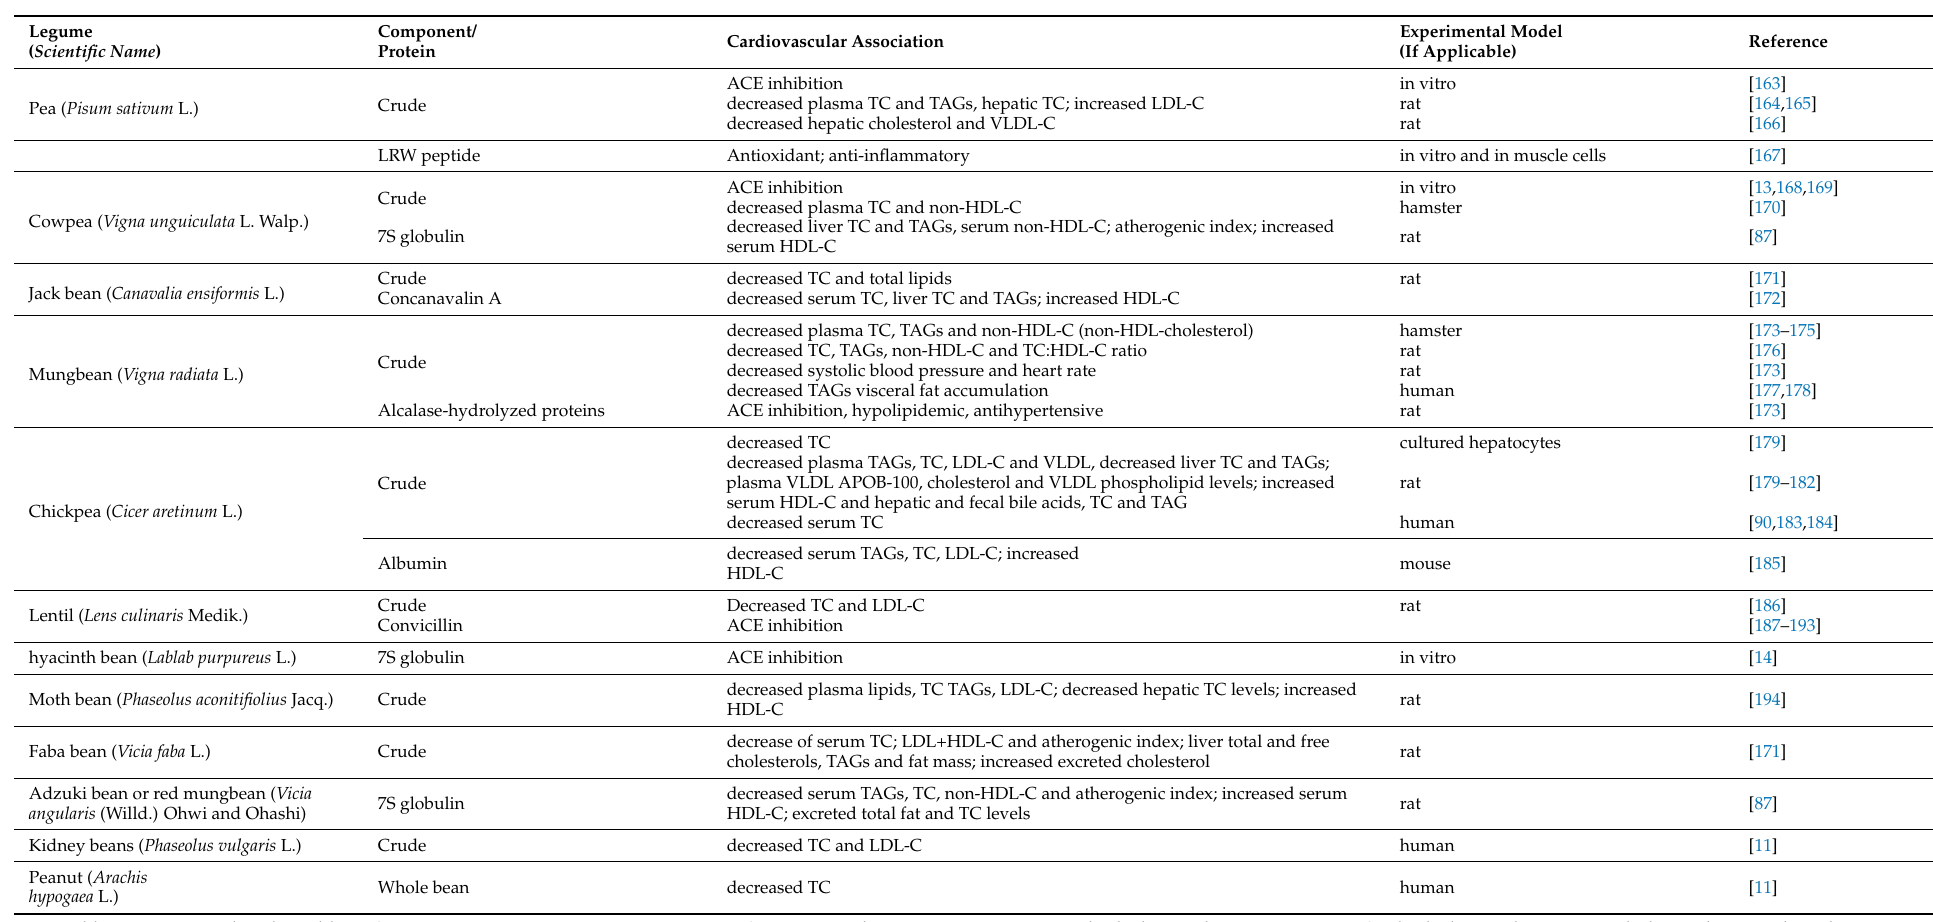
Abbreviations used in this table: ACE = angiotensin-I converting enzyme, APOB-100 = apolipoprotein B-100, HDL = high-density lipoprotein, HDL-C = high-density lipoprotein-cholesterol, LDL = low-density lipoprotein, LDL-C = low-density lipoprotein-cholesterol, LDL-HDL-C = low-density lipoprotein-high-density lipoprotein-cholesterol, LDL:HDL = low-density lipoprotein: high-density lipoprotein ratio, LDL + HDL-C low-density lipoprotein and high-density lipoprotein-cholesterol, TAG = triglycerides, TC = total cholesterol, TC:HDL-C = total cholesterol:high-density lipoprotein-cholesterol, VLDL = very low-density lipoprotein, VLDL-C = very low-density lipoprotein-cholesterol, VLDL-LDL = very low-density lipoprotein-low-density